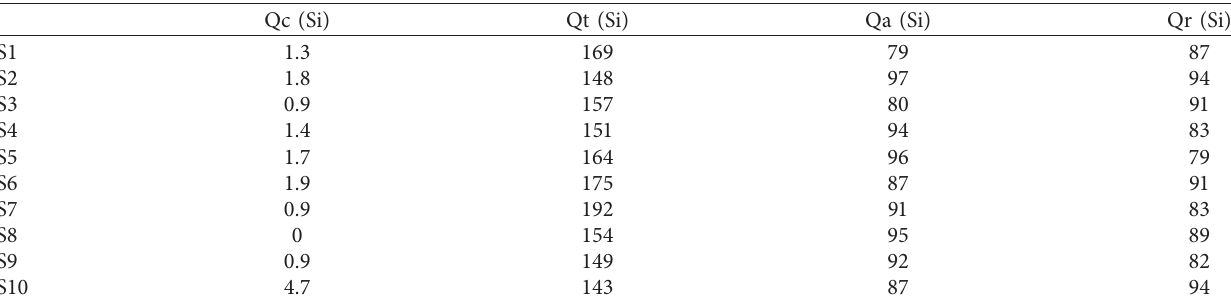
Figure 8: Calculating satisfaction based on similarity. Table 1: Web service QoS